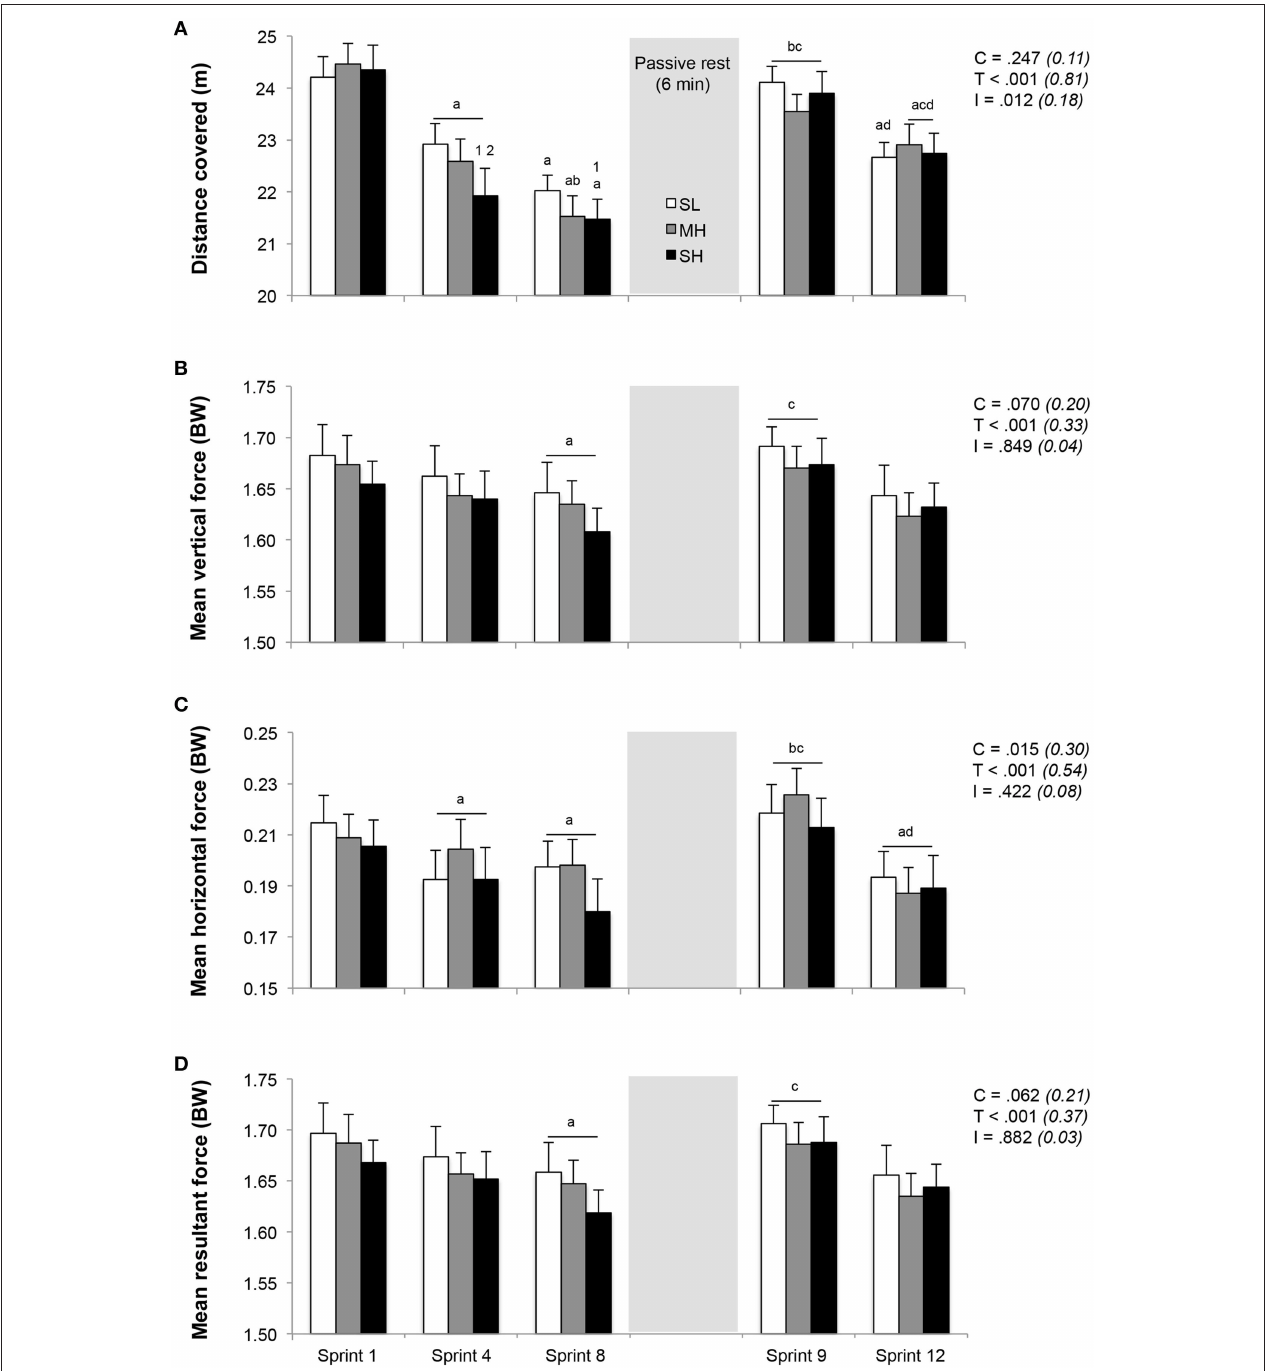
FIGURE 2 | Changes in distance covered (A) and stride kinetics (B, mean vertical force; C, mean horizontal force; D, mean resultant force). Mean ± SD ( n = 13 ). The repeated-sprint exercise protocol included a first set of eight sprints performed at sea level (SL), moderate (MH), or severe hypoxia (SH), while the second set of four sprints was always performed at SL. C, T, and I, respectively refer to ANOVA main effects of condition, time and interaction between these two factors with P -value and partial eta-squared into brackets. a , b , c , and d significantly different from sprint 1, 4, 8, and 9, respectively ( P < 0.05 ). 1 and 2 significant different from SL and MH, respectively ( P < 0.05 ).